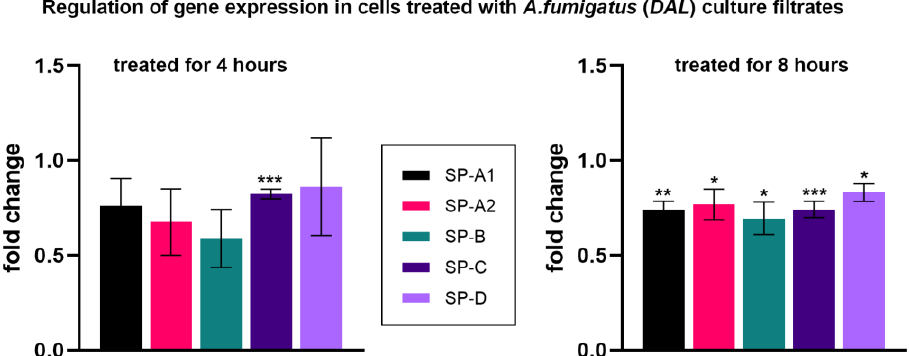
Figure 3. Relative fold change of the mRNA expression levels of SP-A1 , SP-A2 , SP-B , SP-C and SP–D . All data are normalized with RPLP0 rRNA expression and given as relative to untreated control. Cells were treated with culture filtrates obtained from A. fumigatus DAL strain for 4 h (left graph) and 8 h (right graph). Columns depict mean ± SE of the mean (* p ≤ 0.05), (** p ≤ 0.01), (*** p ≤ 0.001). See also Table 1.